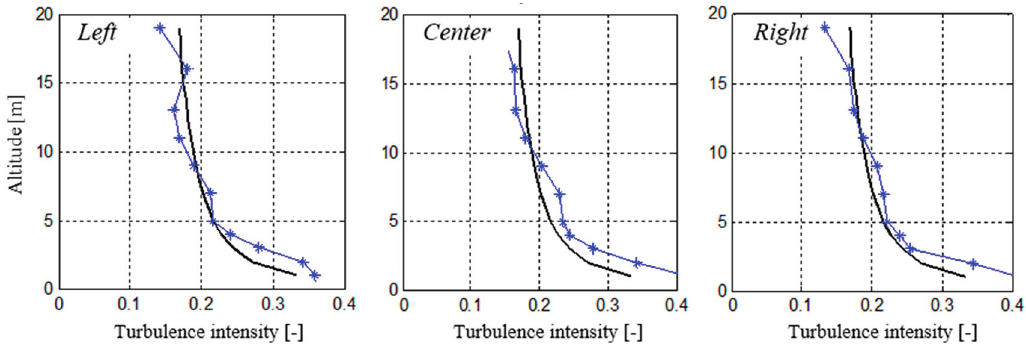
Figure 8. Vertical profile of turbulence intensity. Blue stared: LES results. Black line: